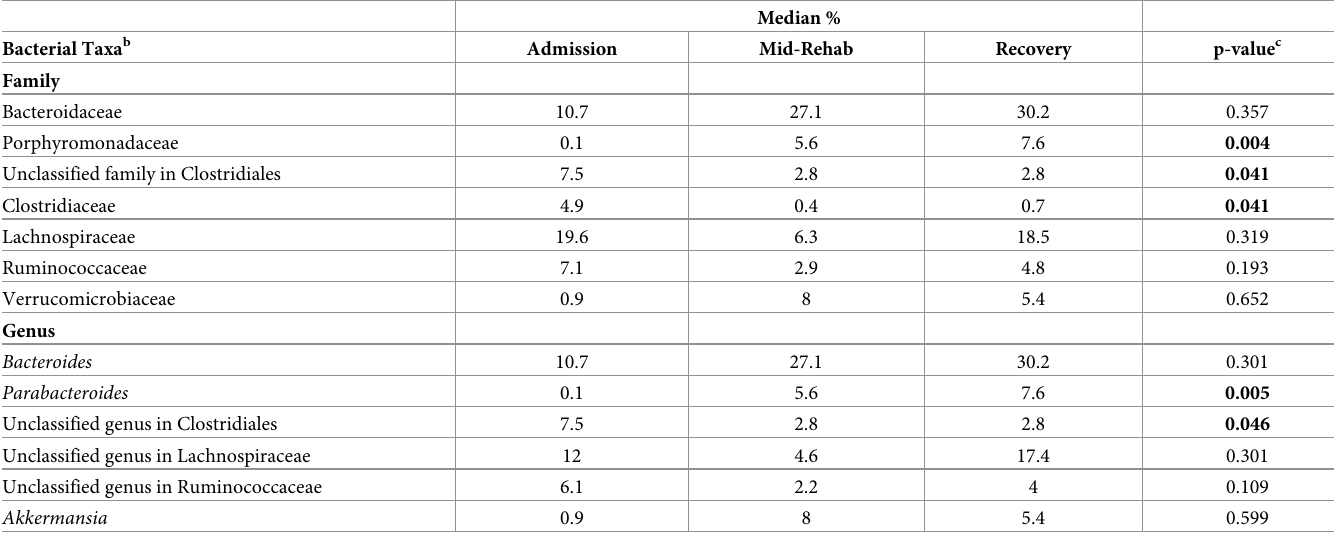
Table 2. Relative abundance of bacterial taxa in feces of juvenile green turtles across three time points in rehabilitation a .